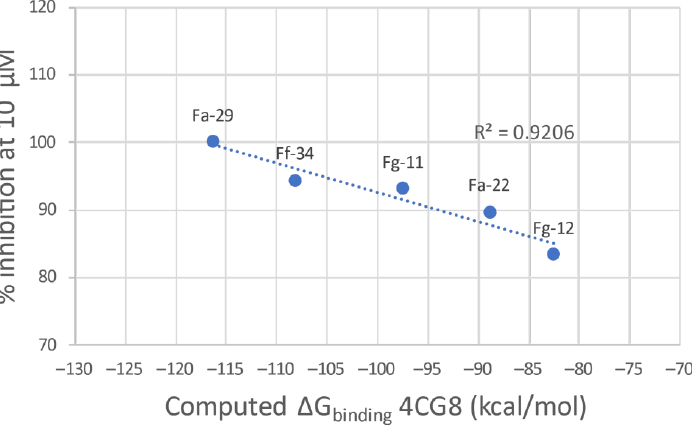
Figure 5. Plot of the calculated ∆ G binding of the most potent compound of each linker class against the experimental percentage inhibitory potency at 10 µM.